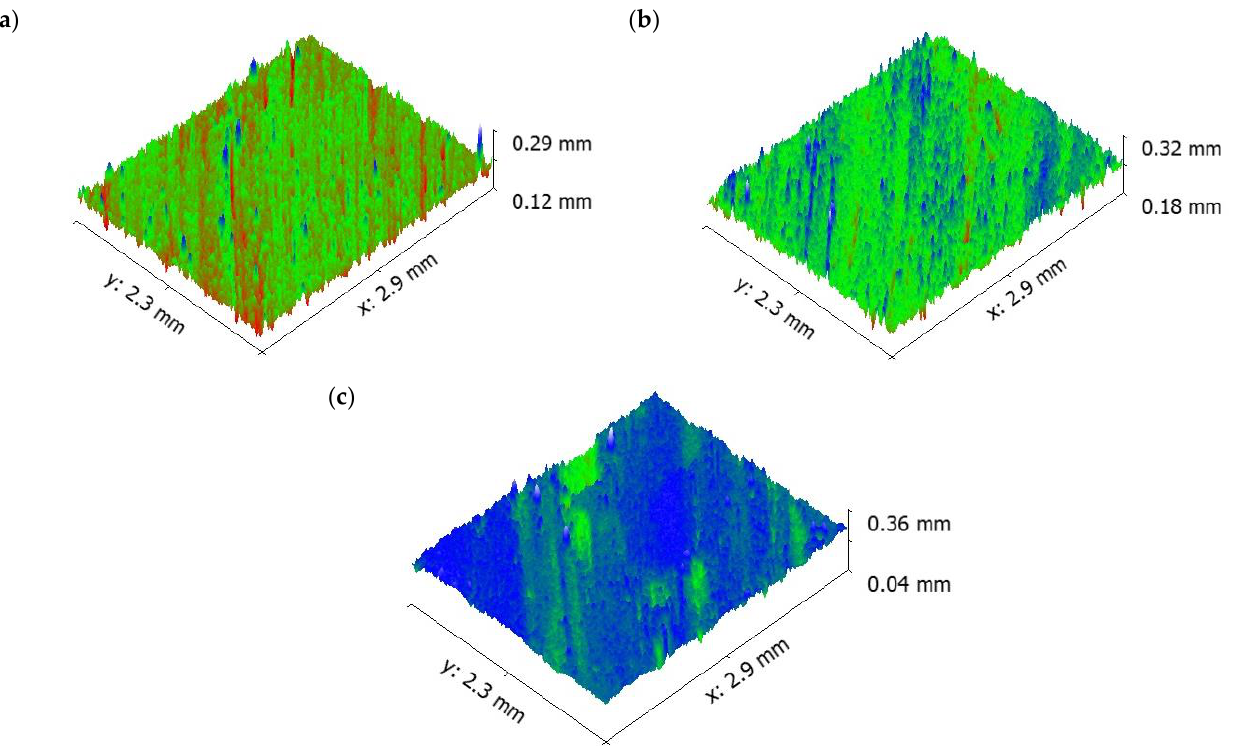
Figure 17. Worn surface topography of the hybrid composite: ( a ) 0.75 m/s ( b ) 1.5 m/s ( c ) 2.25 m/s.